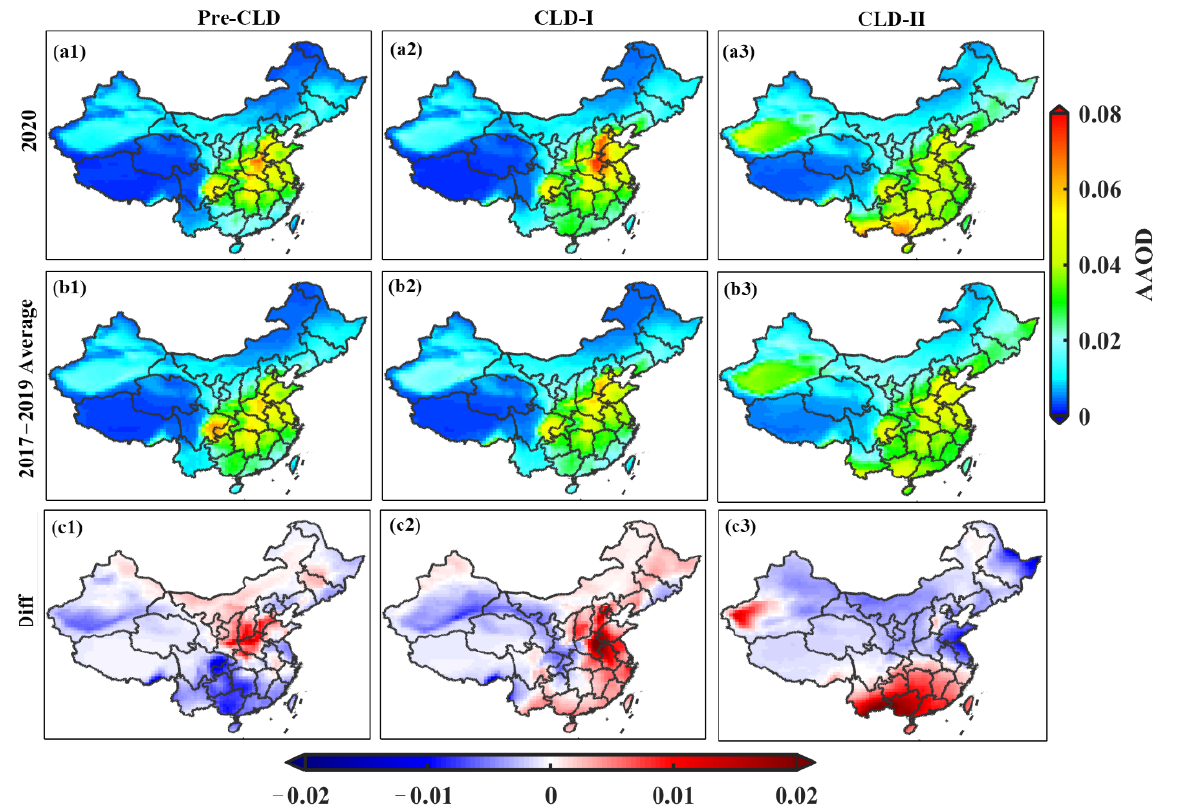
Figure 4. Spatiotemporal distribution of AAOD at 550 nm from MERRA-2 during the Pre-CLD, CLD-I, and CLD-II periods. ( a1 – a3 ) The upper rows showed the data in 2020 and ( b1 – b3 ) the average data in the previous three years (2017–2019) with the same window, respectively. ( c1–c3 ) The lower row shows the differences compared with 2017–2019. The study area’s boundaries and the locations of key cities were displayed in Figure 1.